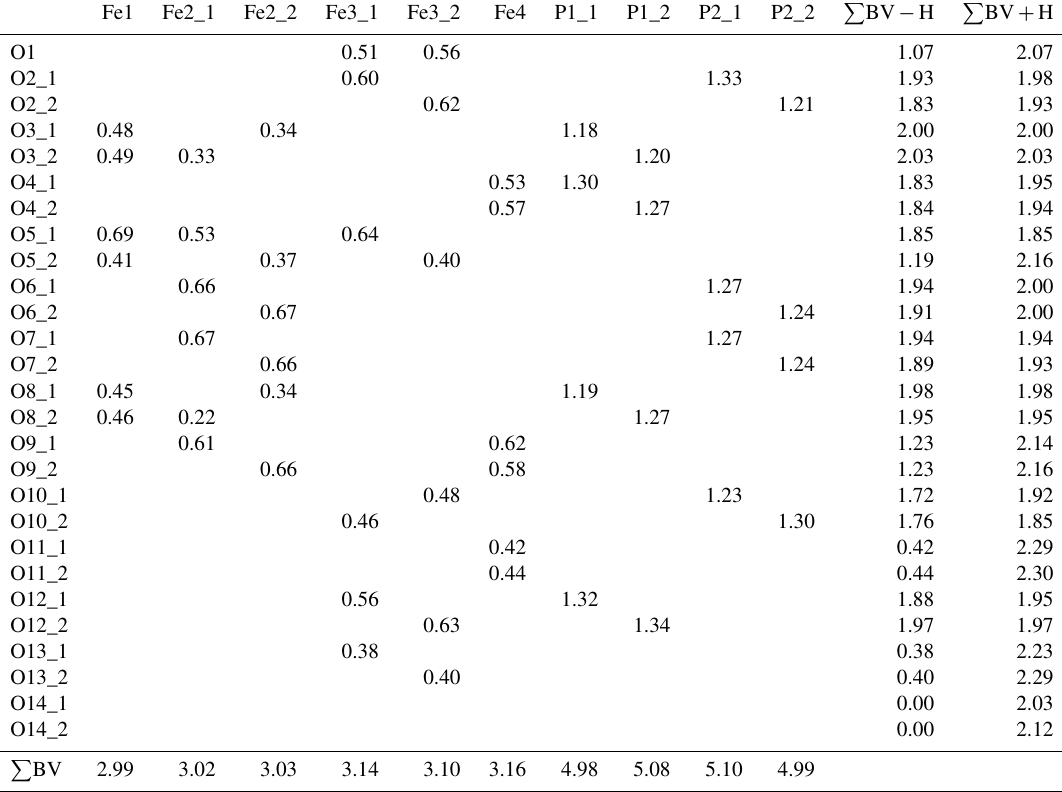
Table 9. Bond-valence analysis for the structure of beraunite (values in valence units, vu).